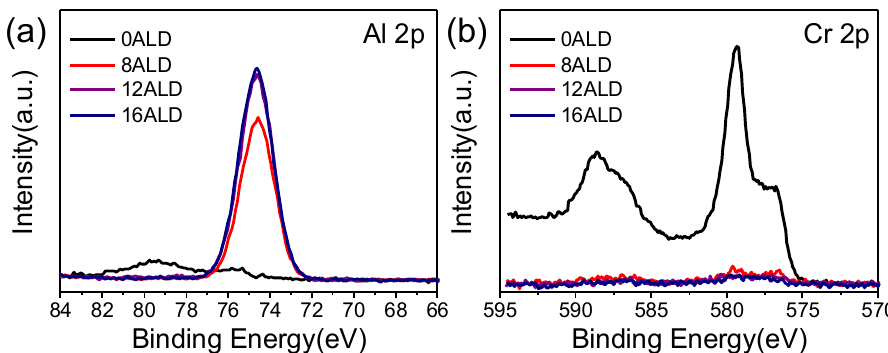
Figure 3. XPS spectra of ( a ) Al 2p, ( b ) Cr 2p with different coating cycle numbers (0, 8, 12, 16).